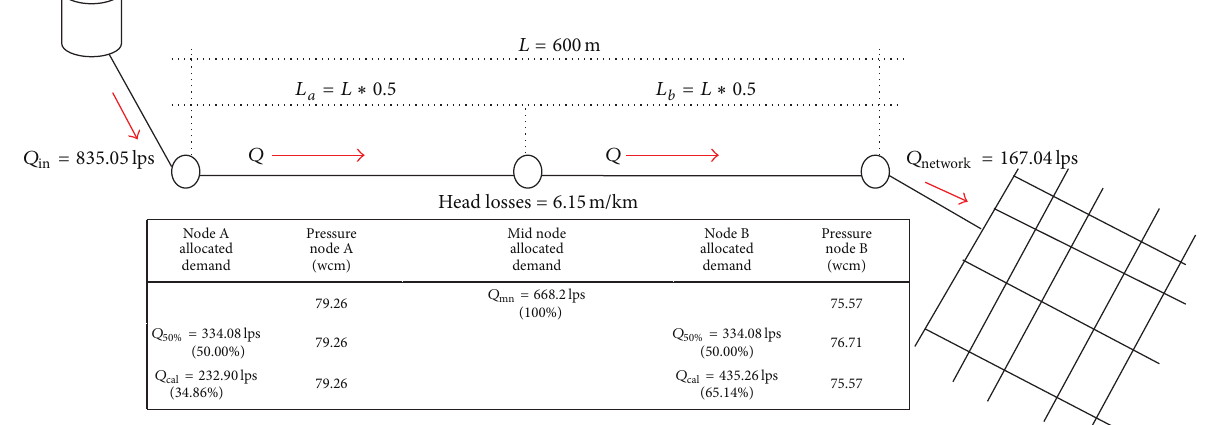
Figure 9: Details and results for Case B.